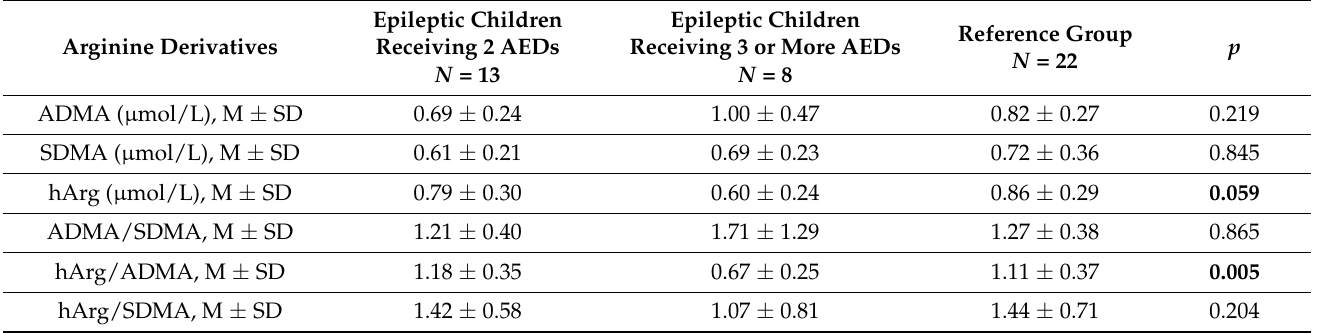
Table 4. Levels of analyzed arginine derivatives in subgroups depending to the number of